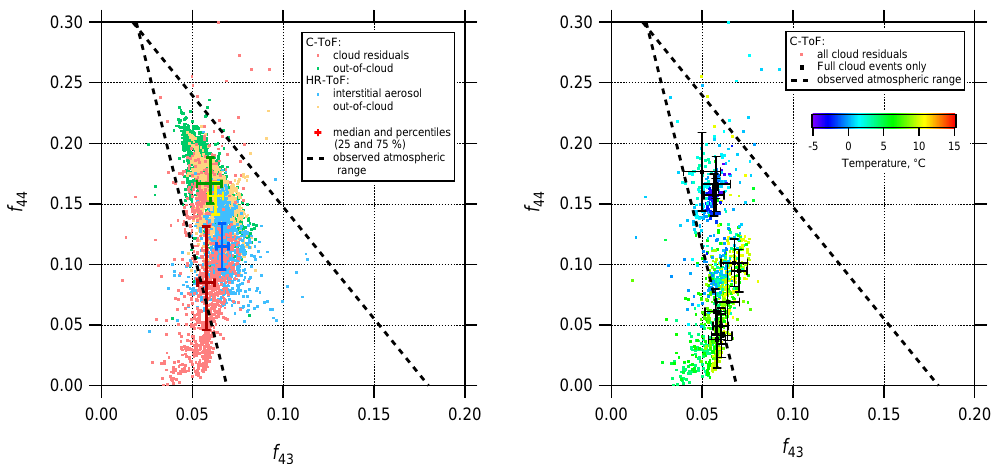
Figure 8. Left panel: f 44 vs. f 43 for cloud residuals (red), interstitial aerosol (blue), and out-of-cloud aerosol (yellow and green) for the whole HCCT-2010 data set. Each data point represents a 15min average. Median and quartiles for all four data sets are given. The dotted lines denote the range of atmospheric values as reported by Ng et al. (2010). Right panel: same plot, but only for cloud residues, color coded by ambient temperature. The averaged values for the full cloud events are given by the black markers. Error bars represent standard